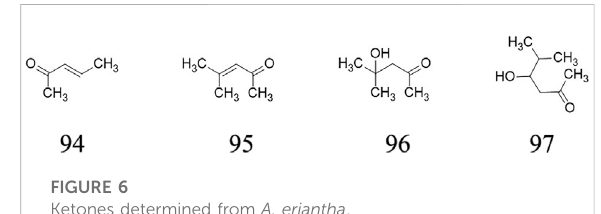
FIGURE 6 Ketones determined from A. eriantha .